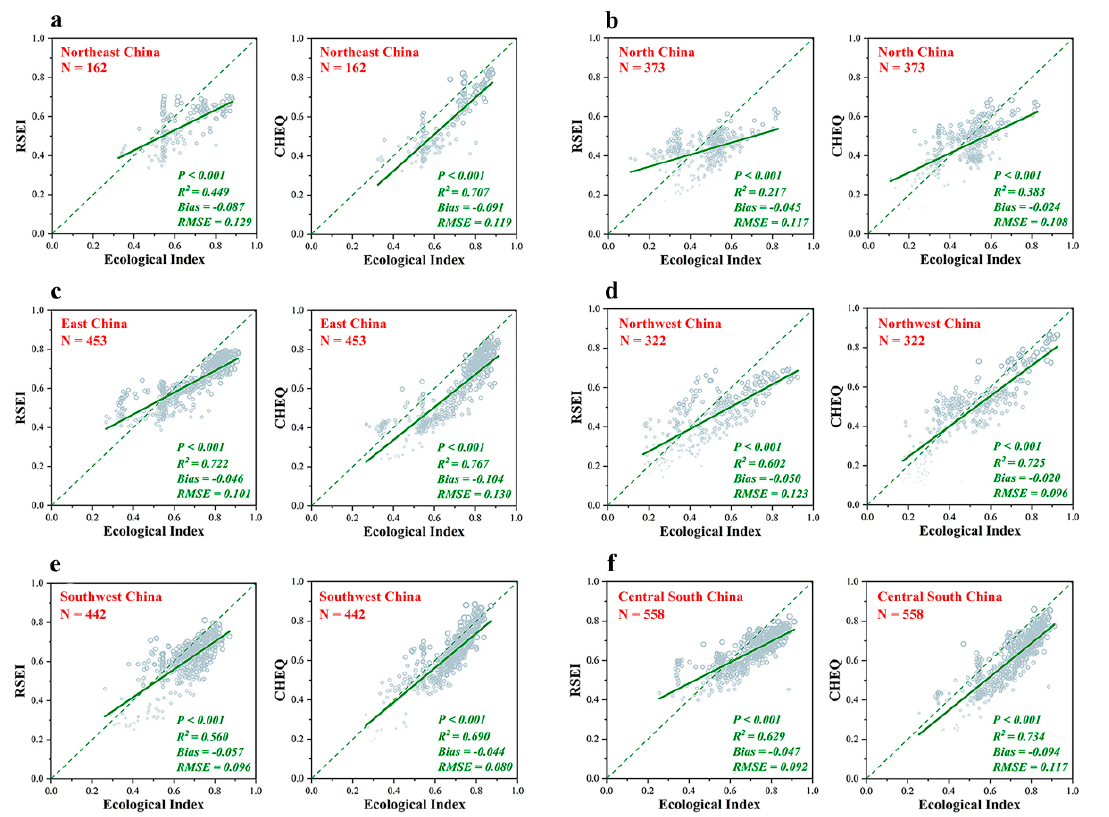
Figure 2. Accuracy verification of CHEQ and RSEI based on ecological index (EI) provided by the Ministry of Ecology and Environment of the People’s Republic of China (MEEPRC): ( a ) Accuracy verification of CHEQ and RSEI in northeast China; ( b ) Accuracy verification of CHEQ and RSEI in north China; ( c ) Accuracy verification of CHEQ and RSEI in east China; ( d ) Accuracy verification of CHEQ and RSEI in northwest China; ( e ) Accuracy verification of CHEQ and RSEI in southeast China; ( f ) Accuracy verification of CHEQ and RSEI in central south China.